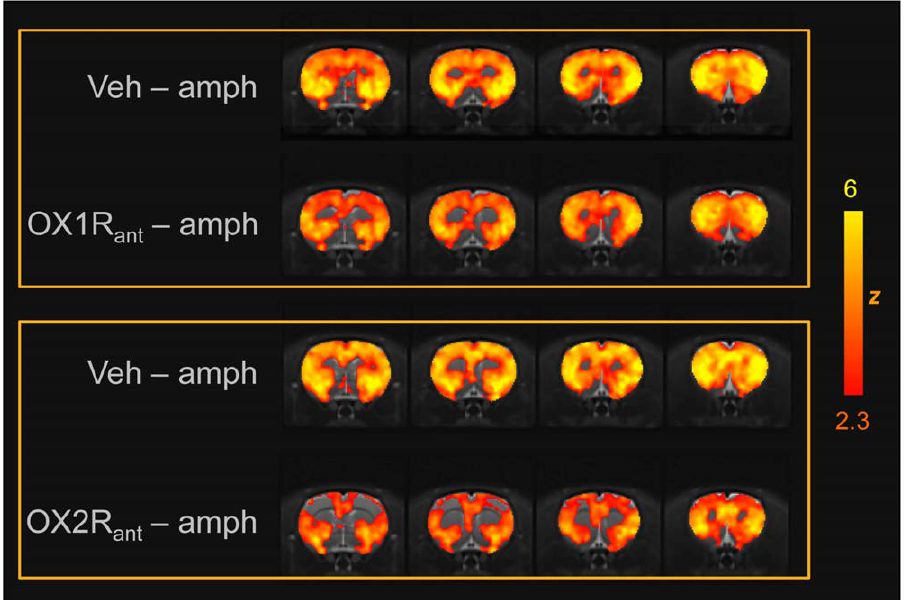
Figure 2. fMRI activation produced by D-amphetamine as a function of pharmacological pre-treatment. Anatomical distribution of the activation produced by D-amphetamine challenge across the different treatment groups. Yellow/orange indicates increased rCBV versus vehicle- vehicle baseline (Group 5). OX1R ant : GSK1059865 (30 mg/kg i.p.); Ox2R ant: : JNJ10397049 (50 mg/kg i.p.).